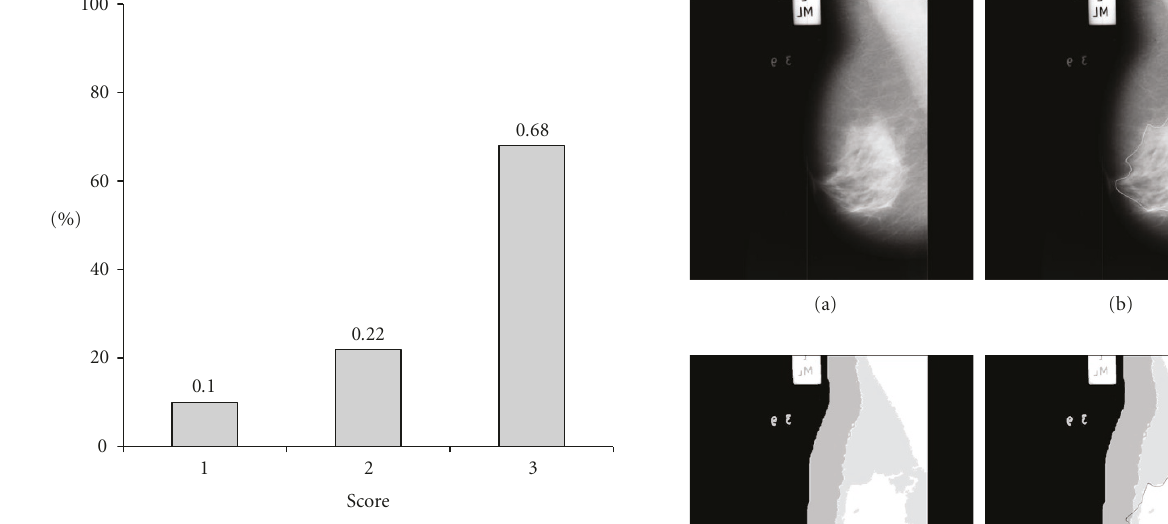
Figure 4: Rating of segmentation results.